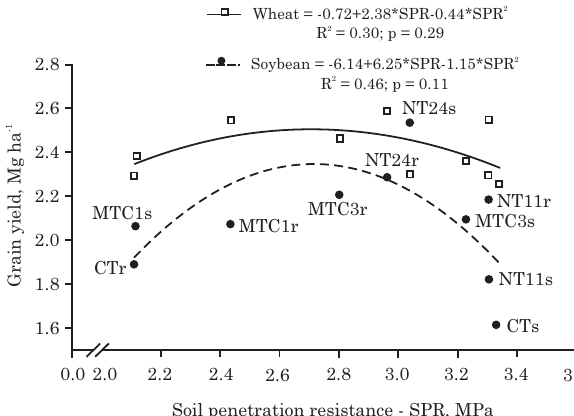
Figure 5. Soybean and wheat grain yield as related to soil penetration resistance at a matric potential of -33 kPa in the 0.10-0.20 m layer under the tillage systems: CT- conventional tillage; MTC 1 - minimum tillage with annual chiseling; MTC 3 - minimum tillage with chiseling every three years; NT 11 -no-tillage for 11 years; NT 24 - no-tillage for 24 years; r - crop rotation; s - crop succession.